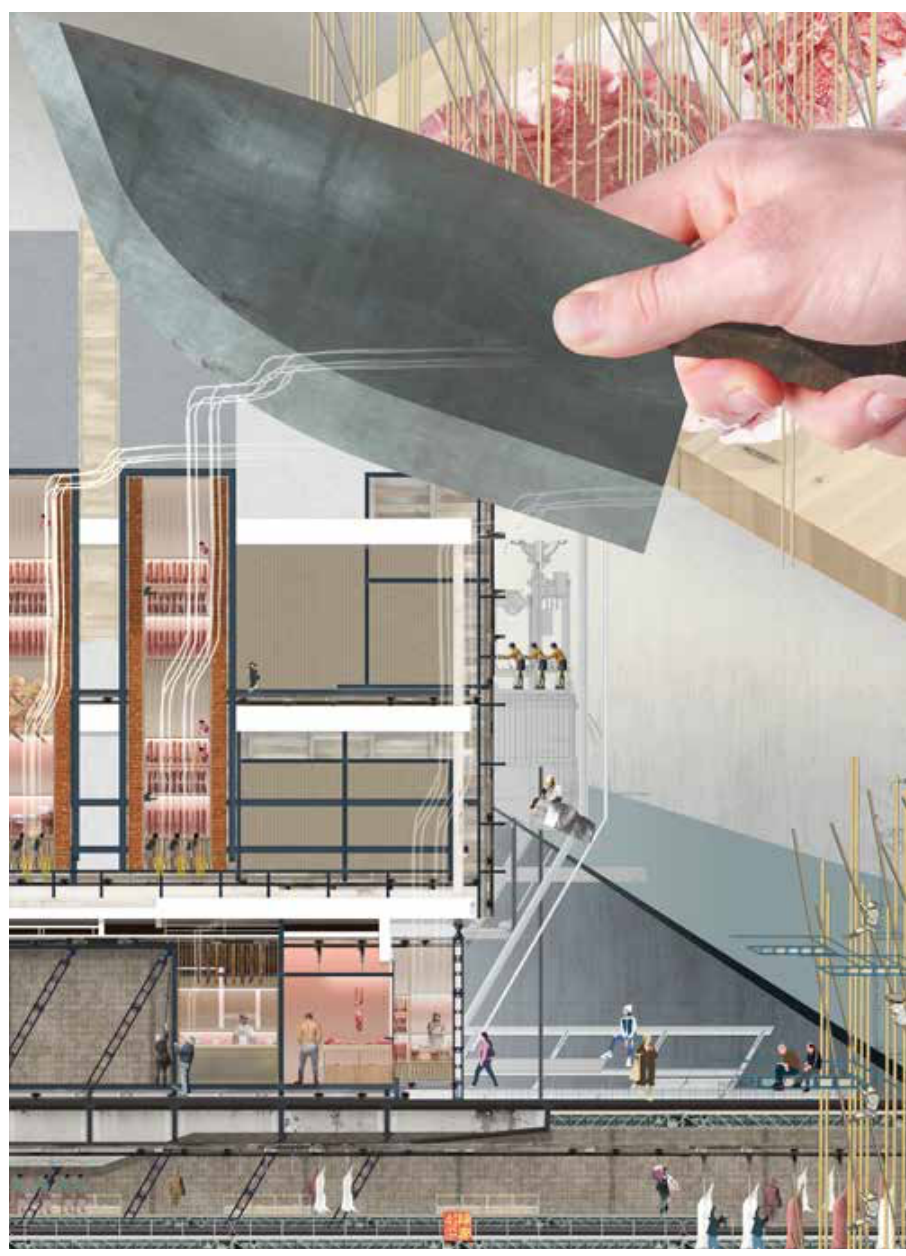
Figure 5: Getting lively, in the morning, chop- ping sound and the street, sounds of metal craft- ing. After the market is operating for a certain time, sitting devices emerge. Elderly sit, relax and wait for friends. Kids stand on it for fun. Source: Olivia